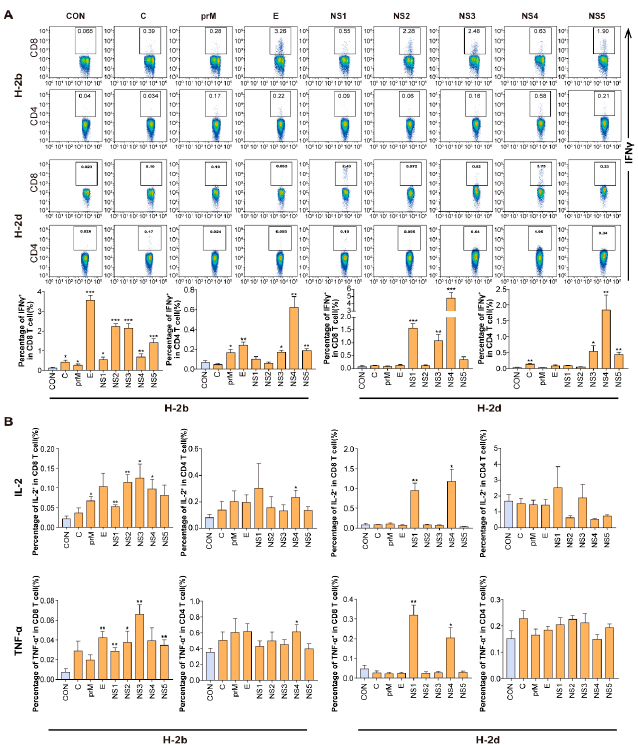
Figure 2. Characterization of ZIKV proteins recognized by CD8+ and CD4+ T cells. ( A , B ) Wild-type C57BL/6 and BALB/c mice ( n = 6 per group) were infected with 10 4 FFU of ZIKV, splenocytes were harvested at 14 d.p.i. and stimulated with different protein libraries (C, prM, E, NS1, NS2, NS3, NS4, NS5) to assess cytokines production of IFN- γ ( A ), TNF- α and IL-2 ( B ) by ICS in CD8+ and CD4+ T cells. A Student’s t -test was performed Error bars represent SEM; * p < 0.05; ** p < 0.01; *** p < 0.001. 3.2. The Profile Mapping of Antigenic Peptides across the Whole ZIKV Polyprotein in Mice To verify the map of the T-cell response to ZIKV, all 364 peptides spanning the ZIKV proteome were tested by IFN- γ -ELISPOT assays using matrix peptide pools in ZIKV-in- fected wild-type mice. The T-cell responses to ZIKV in H-2 b and H-2 d mice were not iden- tical, with more H-2 b -positive epitopes than H-2 d -restricted ones. Among the eight ZIKV proteins, 91 peptides were positive for H-2 b and 39 for H-2 d . For H-2 b mice, positive epitopes were derived from C (1/13), prM (3/17), E (25/53), NS1 (14/38), NS2 (8/37), NS3 (8/66), NS4 (12/41) and NS5 (20/99), with immune hotspots in E and NS1 proteins. For H- 2 d mice, distribution of the positive peptides among the eight proteins were C (2/13), prM